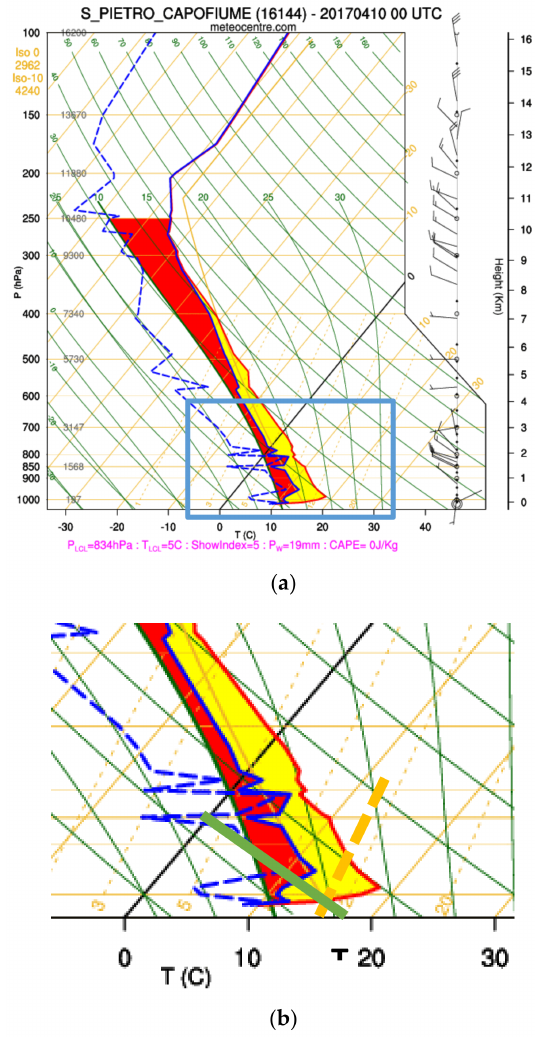
Figure 8. Skew T Log P diagram and a zoom of the blue rectangular region of the radiosonde launched from San Pietro Capofiume (44.6539 ◦ N, 11.6225 ◦ E) launching station. Measurement from 2017-04-10 at 00:00 UTC: ( a ) Skew T Log P diagram between 0 and 16 km altitudes; ( b ) Zoomed Skew T Log P diagram between 0 and 4 km altitudes.